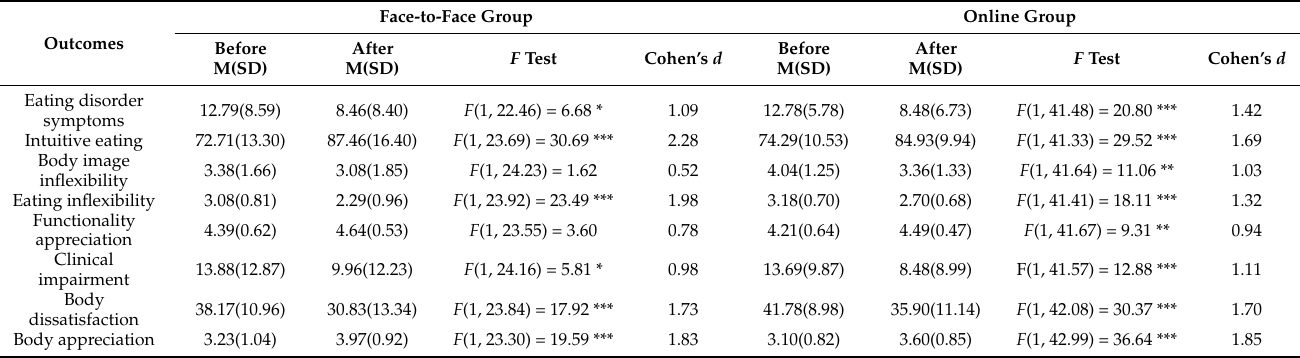
Table 3. Intervention effects.